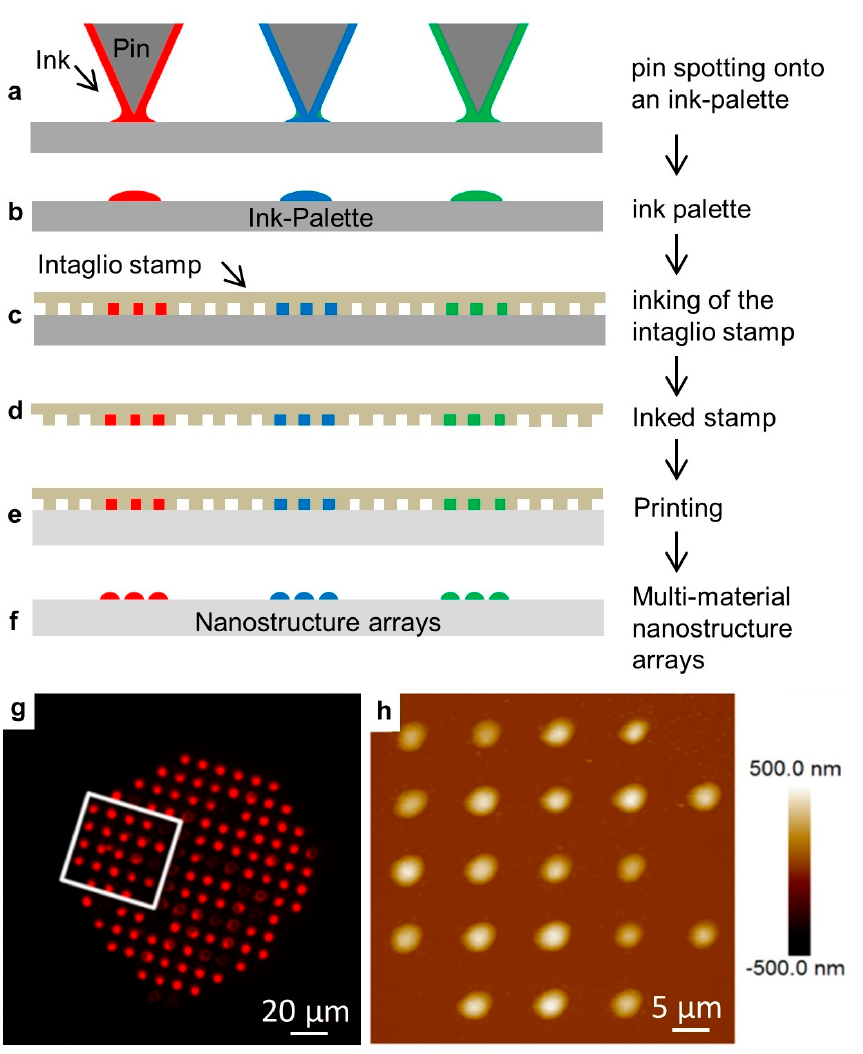
Figure 3. The nanointaglio printing process. ( a – f ) Schematic illustration of the nanointaglio process. ( a , b ) An ink palette is prepared by spotting inks onto surface. ( c , d ) A microstructured polymer stamp is inked by placing the stamp in contact with the palette. ( e ) The inked stamp is used to print from the recesses of the stamp. Initial prints are discarded as excess ink is removed from the surface of the stamp until intaglio printing occurs. ( f ) The printed droplet arrays. ( g ) Fluorescence micro- graph of a printed droplet array. ( h ) Atomic force micrograph of the area outlined in ( g ).